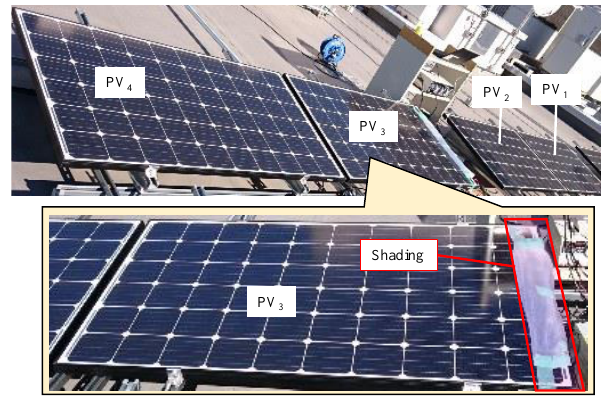
Figure 17. Experimental setup for field testing.